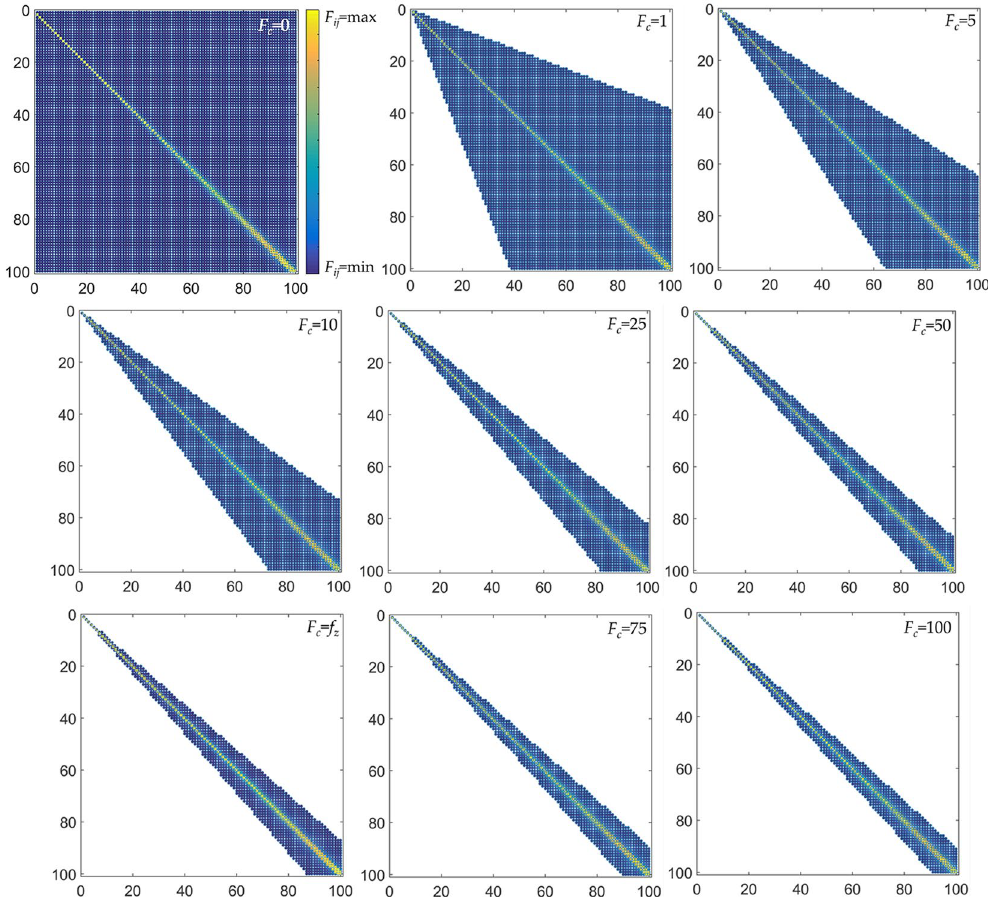
Figure 3. Sparsity (spy) plots of the ESGs that are associated with the series X 1:100 = {1, 2,…, 100} and are computed for the connectivity thresholds F c = 0, F c = 1, F c = 5, F c = 10, F c = 25, F c = 50, F c = f z , F c = 75, and F c =